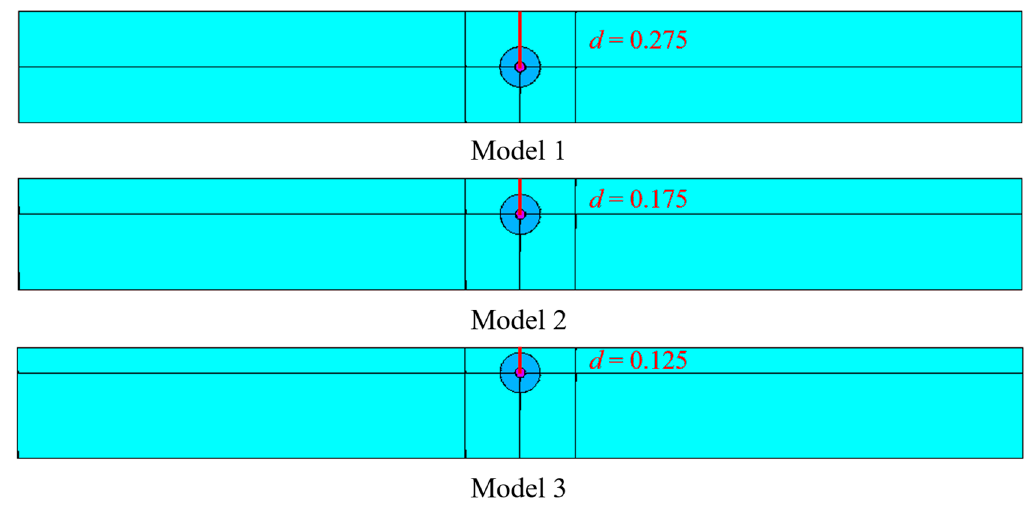
Figure 3. Planes perpendicular to the z axis of three models.